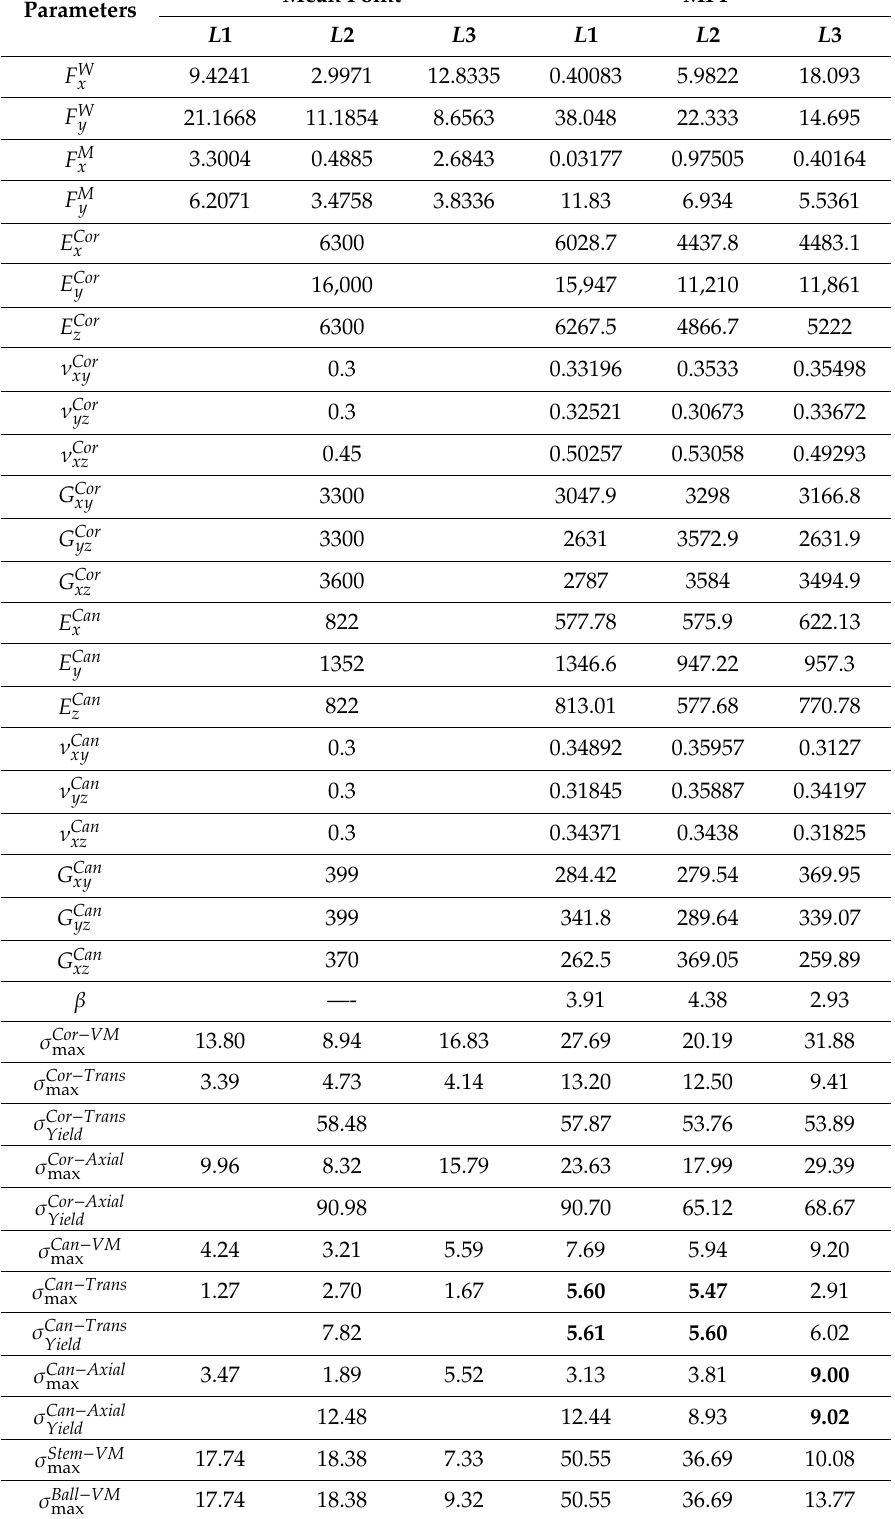
Table 5. Input and output parameters of the developed reliability algorithm.